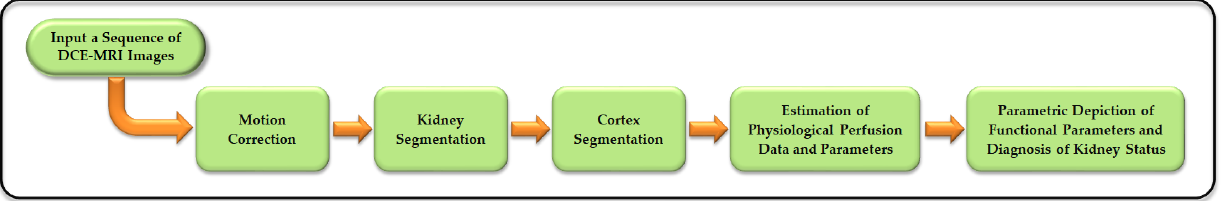
Figure 2. Block diagram of a typical DCE-MRI-based CAD system for the diagnosis of chronic kidney disease.